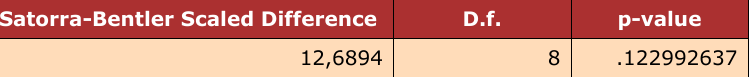
Table 9. Difference of adjusted Satorra-Bentler Chi Squared